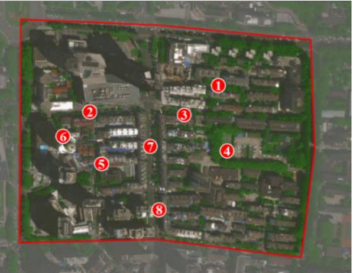
Figure 7. The field measurement points.